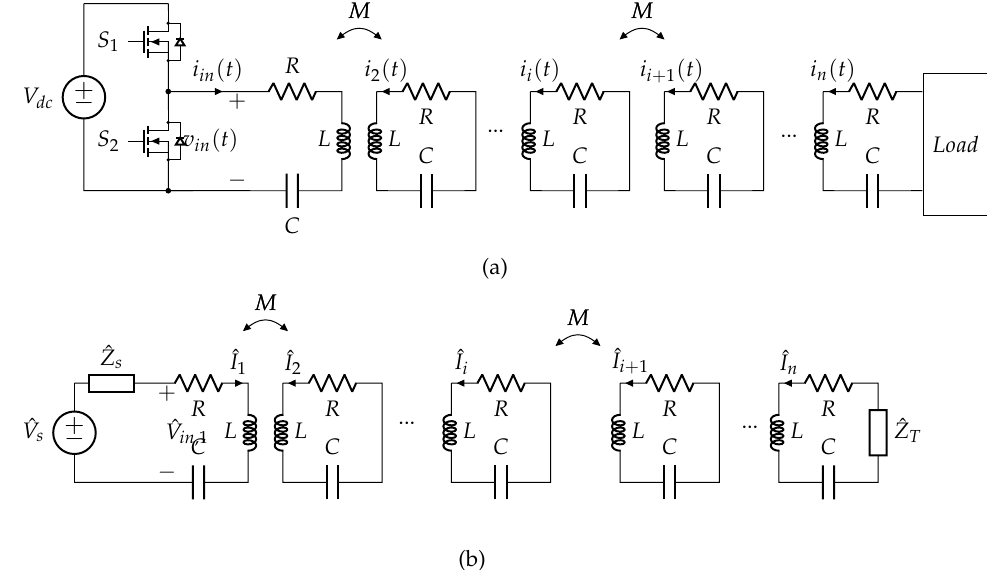
Figure 2. Equivalent circuits of a resonator array ( a ) circuit fed by a half-bridge inverter and connected to a load and ( b ) approximate circuit for the first